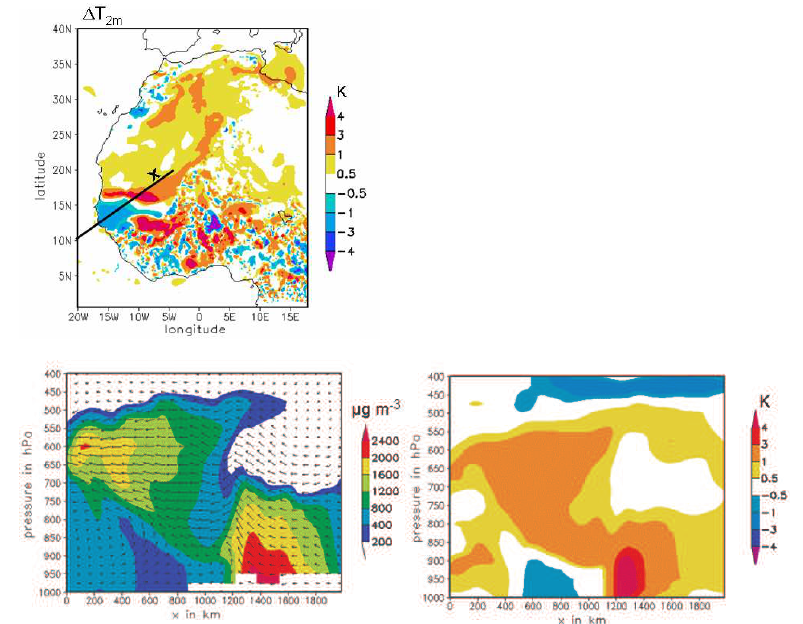
Figure 11: Simulated difference in 2 m temperature in K between runs F and CTRL (top) and vertical cross section of mass concentration of mineral dust (bottom left) and difference in potential temperature (bottom right) along the line indicated by x on 21 June 2007, 15 UTC.